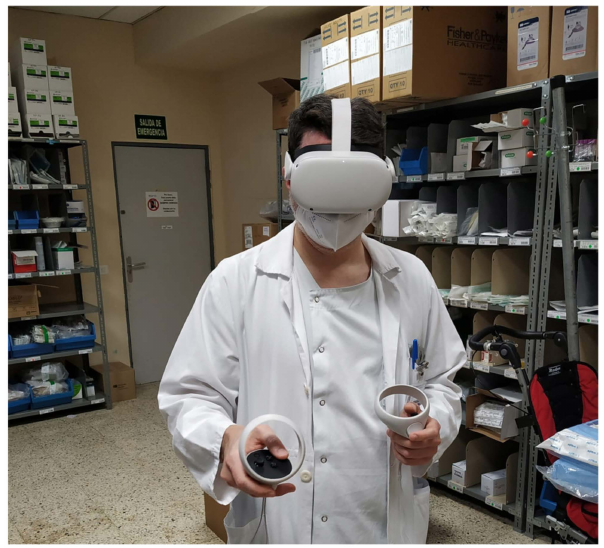
Figure 4. User interacting with the